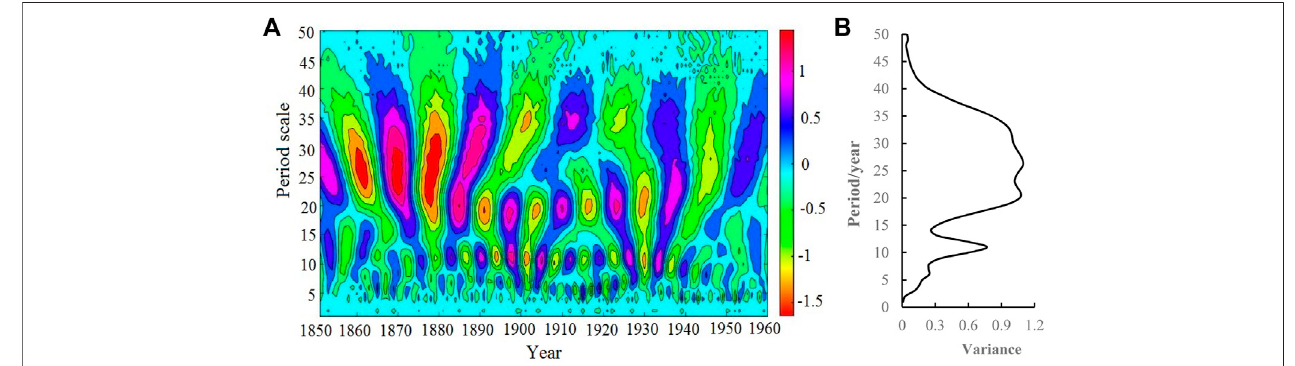
FIGURE6| Thesliding t -teststatisticcurveofdroughtand fl oodlevelsintheQinlingmountainsfrom1850to1959(orangelineisthethresholdvaluelineofthe95% t-distribution; thin black dashed line is the change line of the drought and fl ood sequence; thick black line is the statistic curve of the t -test; × is a mutation point).